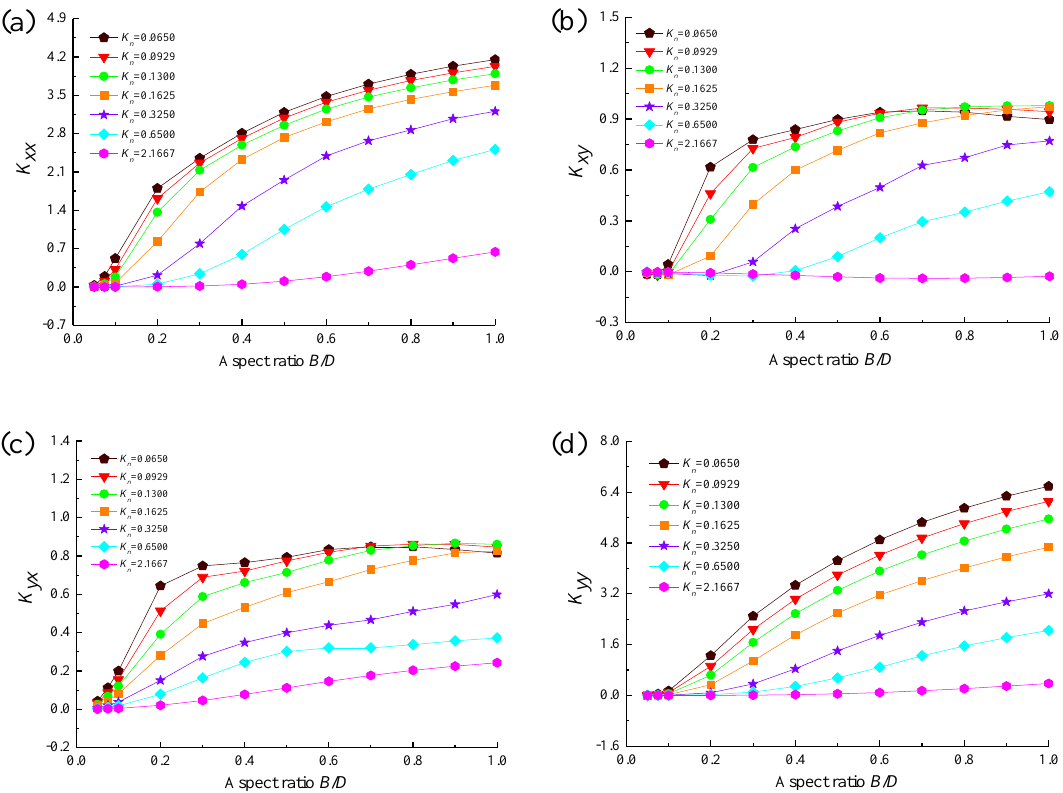
Figure 13. Stiffness coefficients of Boltzmann model against the aspect ratio B / D for various Knudsen numbers. ( a ) K xx vs. B / D ; ( b ) K xy vs. B / D ; ( c ) K yx vs. B / D ; ( d ) K yy vs. B / D.